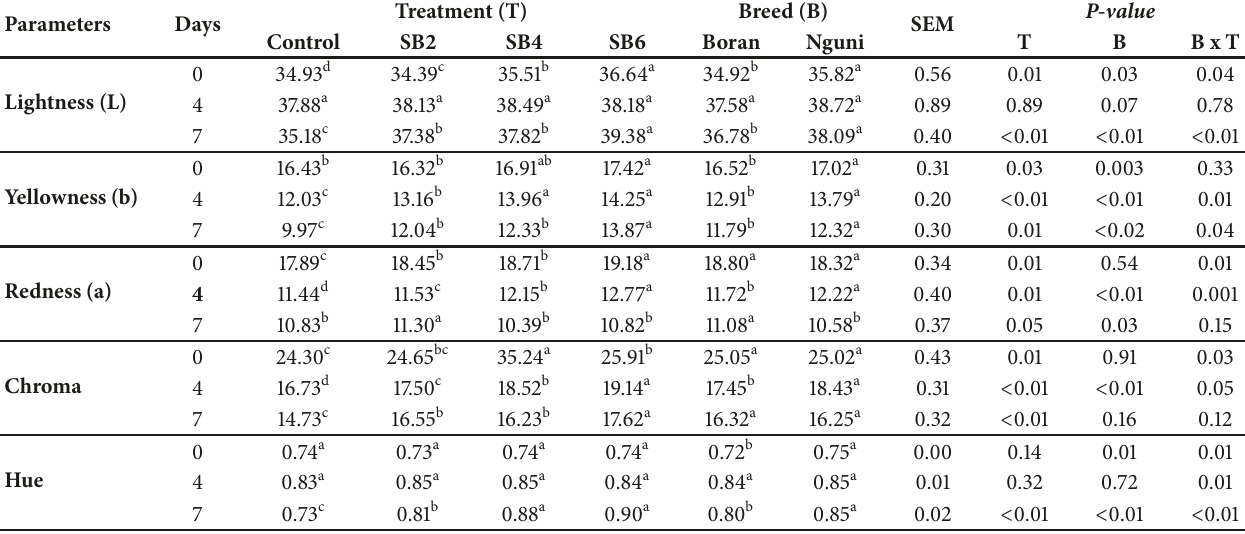
Table 3: Preservative effect of sweet basil essential oil on colour stability of minced beef from Boran and Nguni cattle during cold storage at 4 ∘